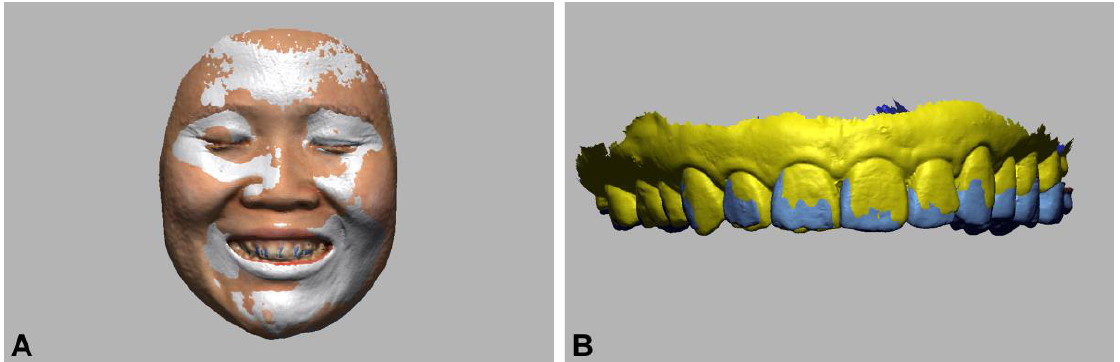
Figure 5. ( A ) Orientation of the integrated dentofacial model into the reference image; ( B ) dental images for accuracy evaluation.